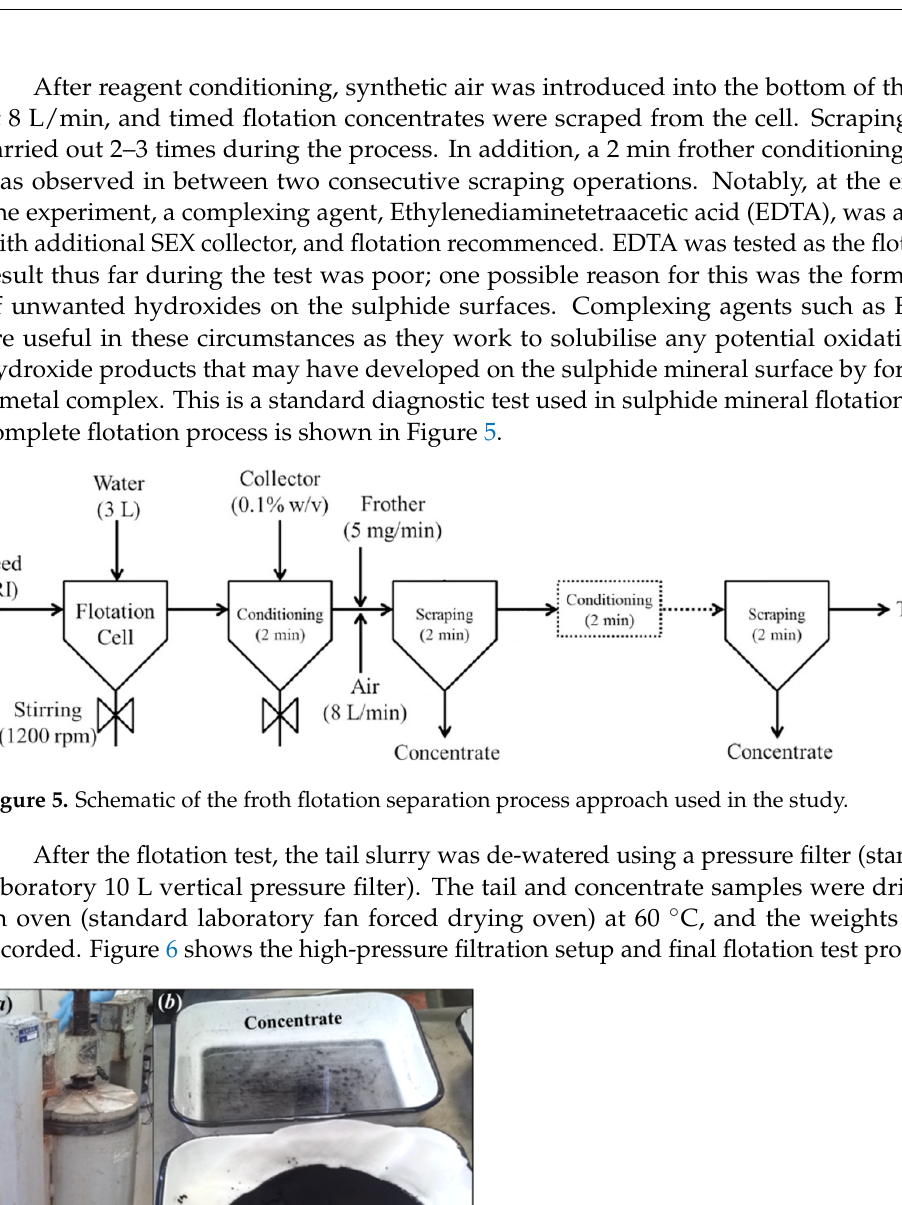
Figure 4. Laboratory-scale 3L stainless steel flotation cell used in this study.